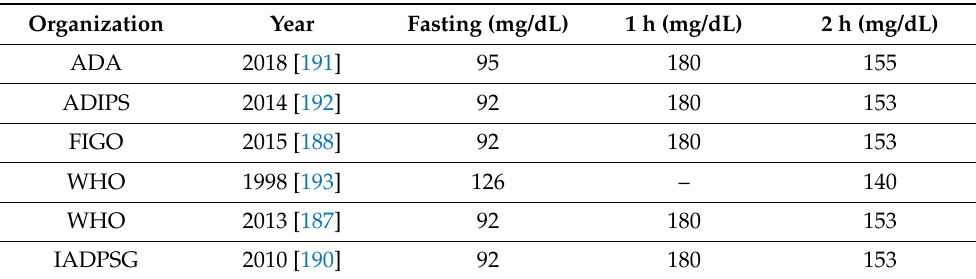
Table 6. Diagnostic criteria for